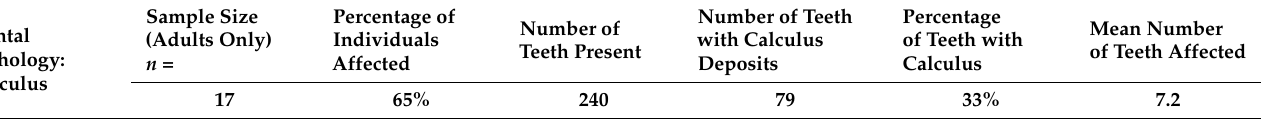
Table 4. Calculus—the percentage of individuals and the number of teeth with calculus deposits.